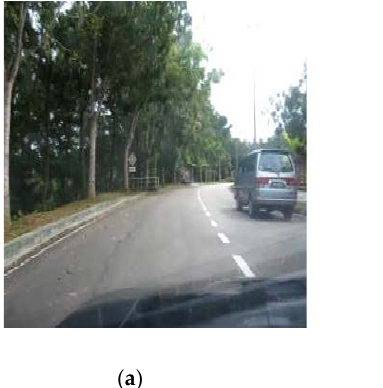
Figure 19. Autonomous detection and navigation of the proposed system in the road following (with